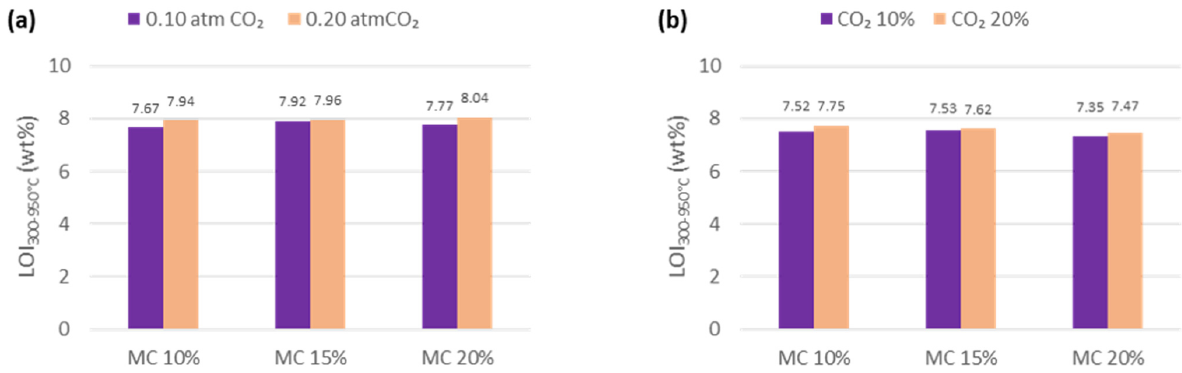
Figure 4. CO 2 content (LOI 300–950 ◦ C ) of incubator carbonated (144 h) kimberlite at ( a ) 35 ◦ C and ( b ) 50 ◦ C where MC represents Scheme 2 content (LOI 300–950 ◦ C ) of unreacted kimberlite is 7.3 wt%.